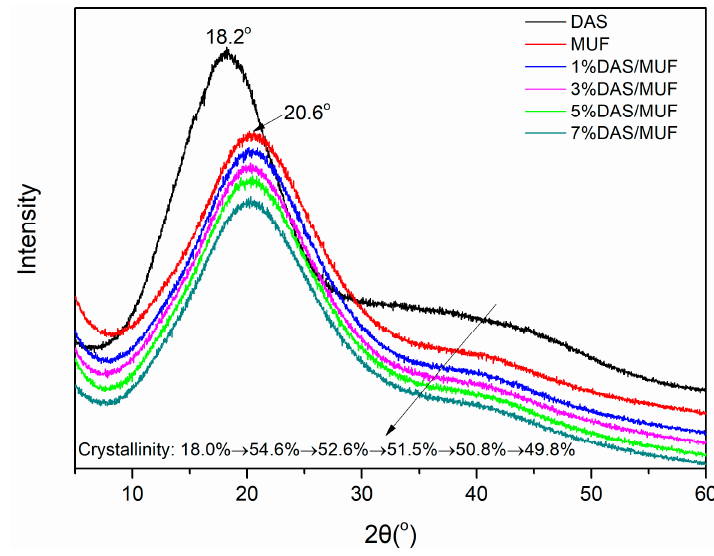
Figure 6. XRD patterns of DAS, the cured MUF resin and DAS-modified MUF resins with di ff erent DAS levels.